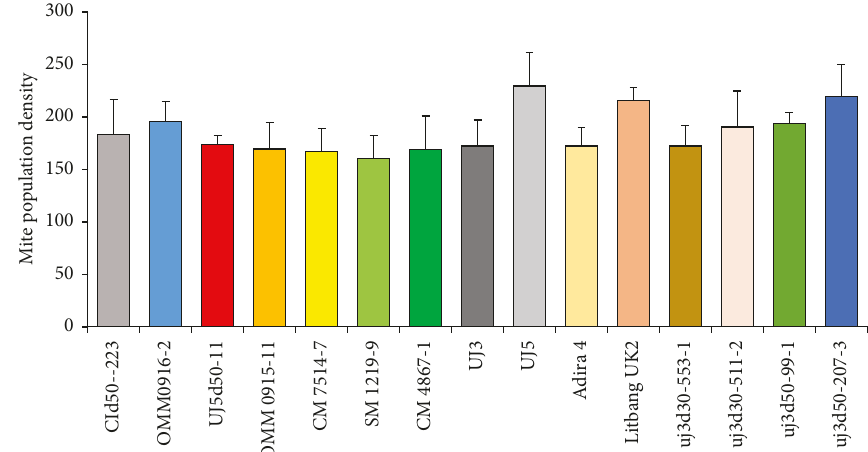
Figure 3: Total of mite population ( Table 4: The damage intensity of mite attack ( Clones